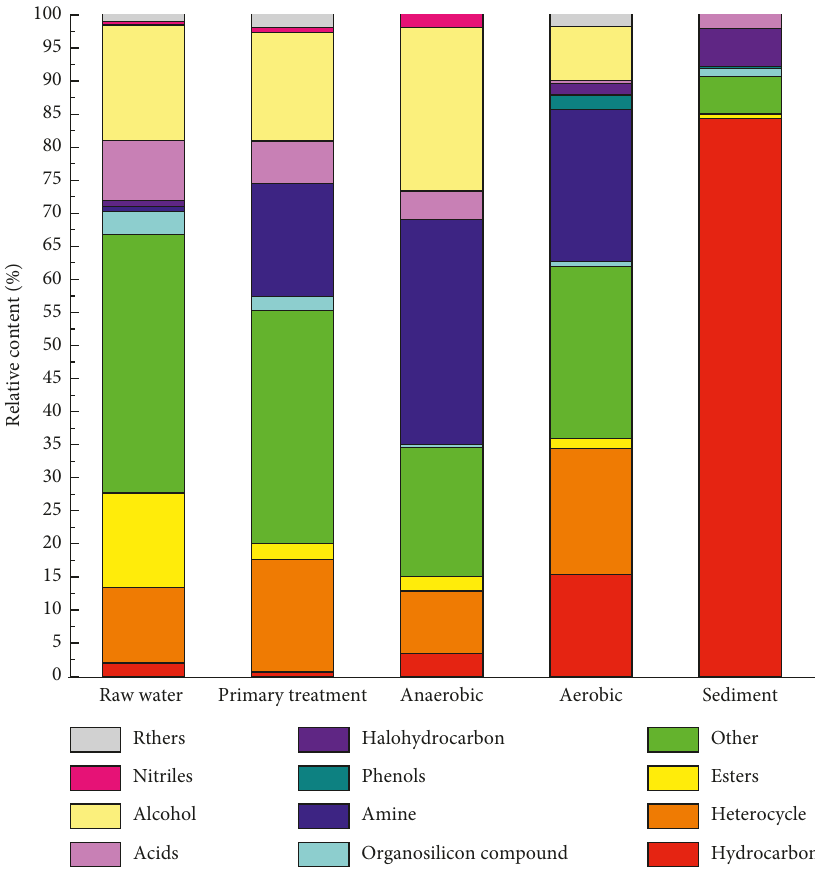
Figure 6: Relative contents of organic compound classes during each stage of typical traditional treatment